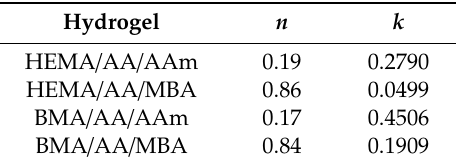
Table 3. Estimated parameters obtained from fitting the ca ff eine release experimental data at pH 7 to the Ritger–Peppas